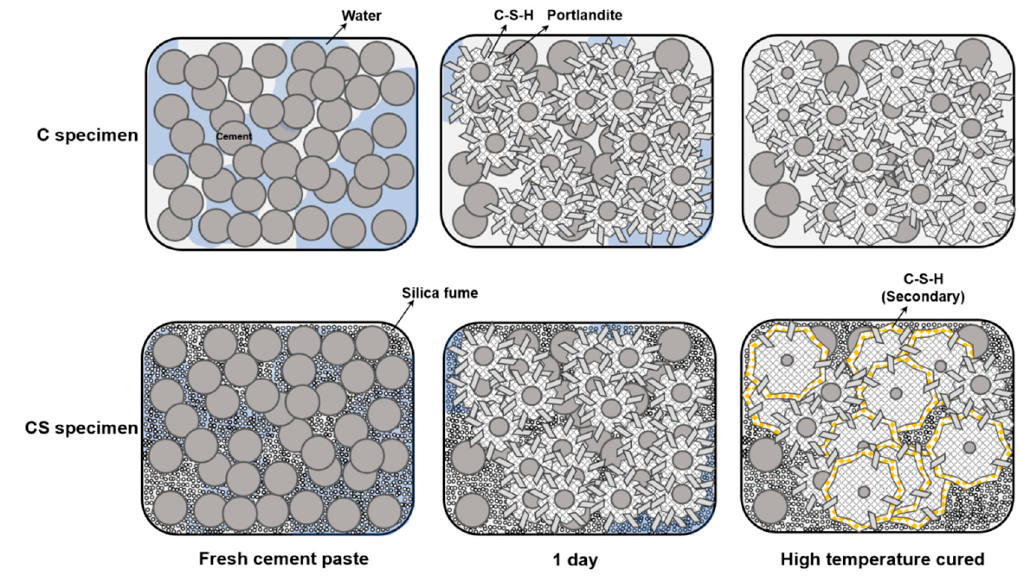
Figure 8. Schematic representation of the cement hydration and pozzolanic reaction under a low w/c ratio.